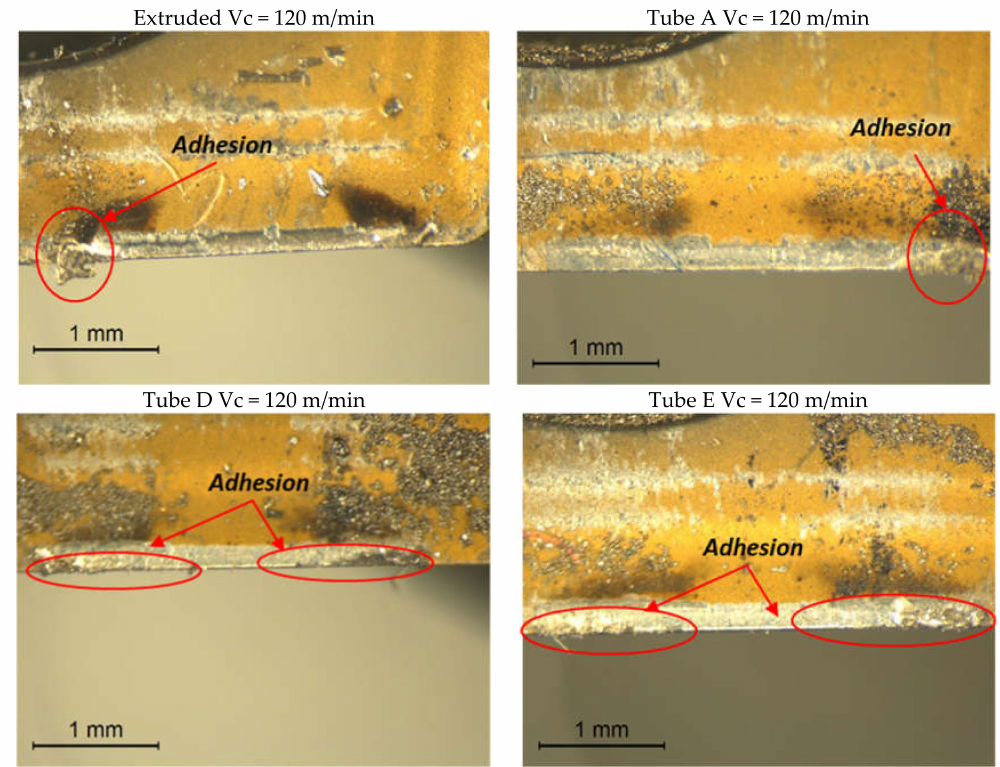
Figure 7. Rake face of the cutting tool tip used for machining the extruded and the AM tubes with Vc at 120 m /